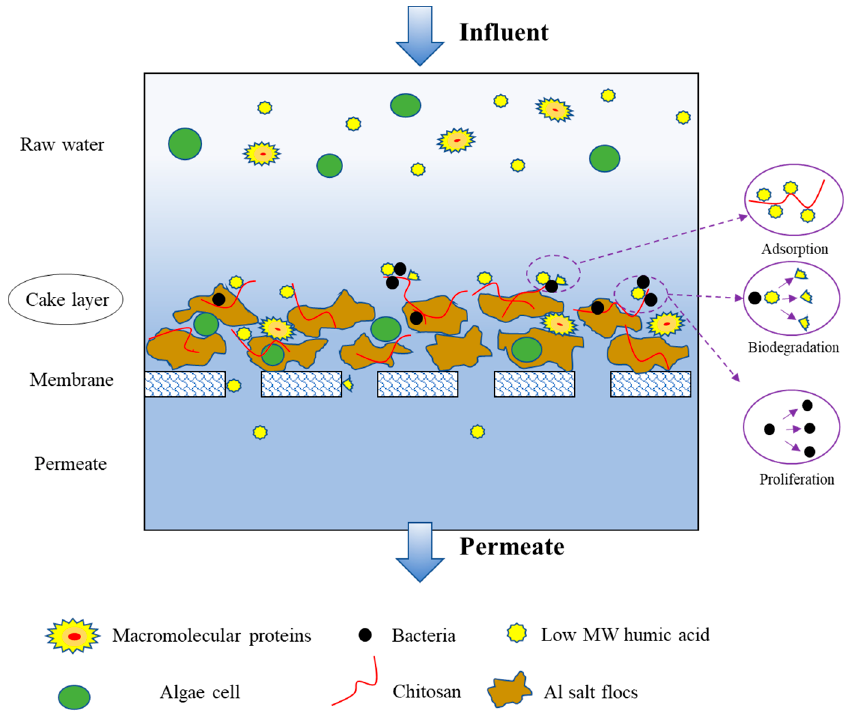
Figure 10. The mechanism of membrane fouling mitigation in the AS-CS / GDM system.